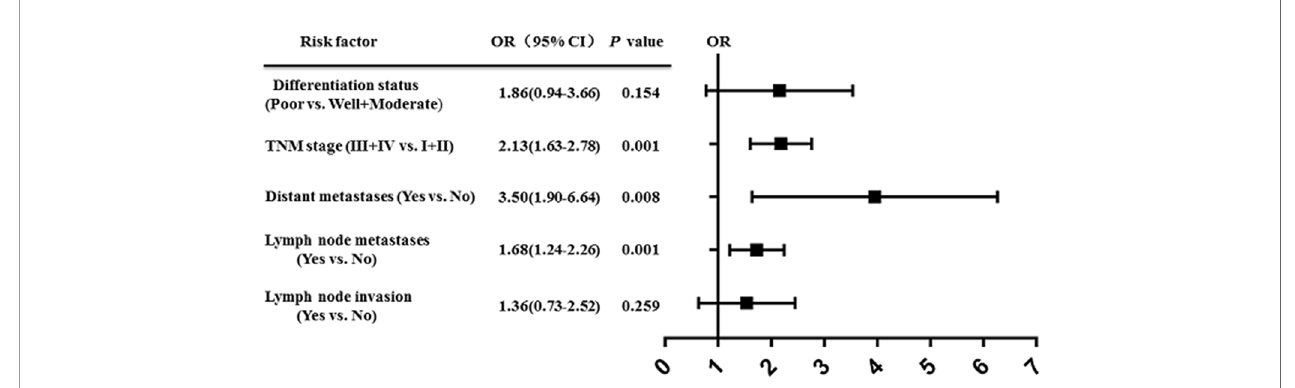
FIGURE 4 | High expression of CDR1as is related to the clinicopathology